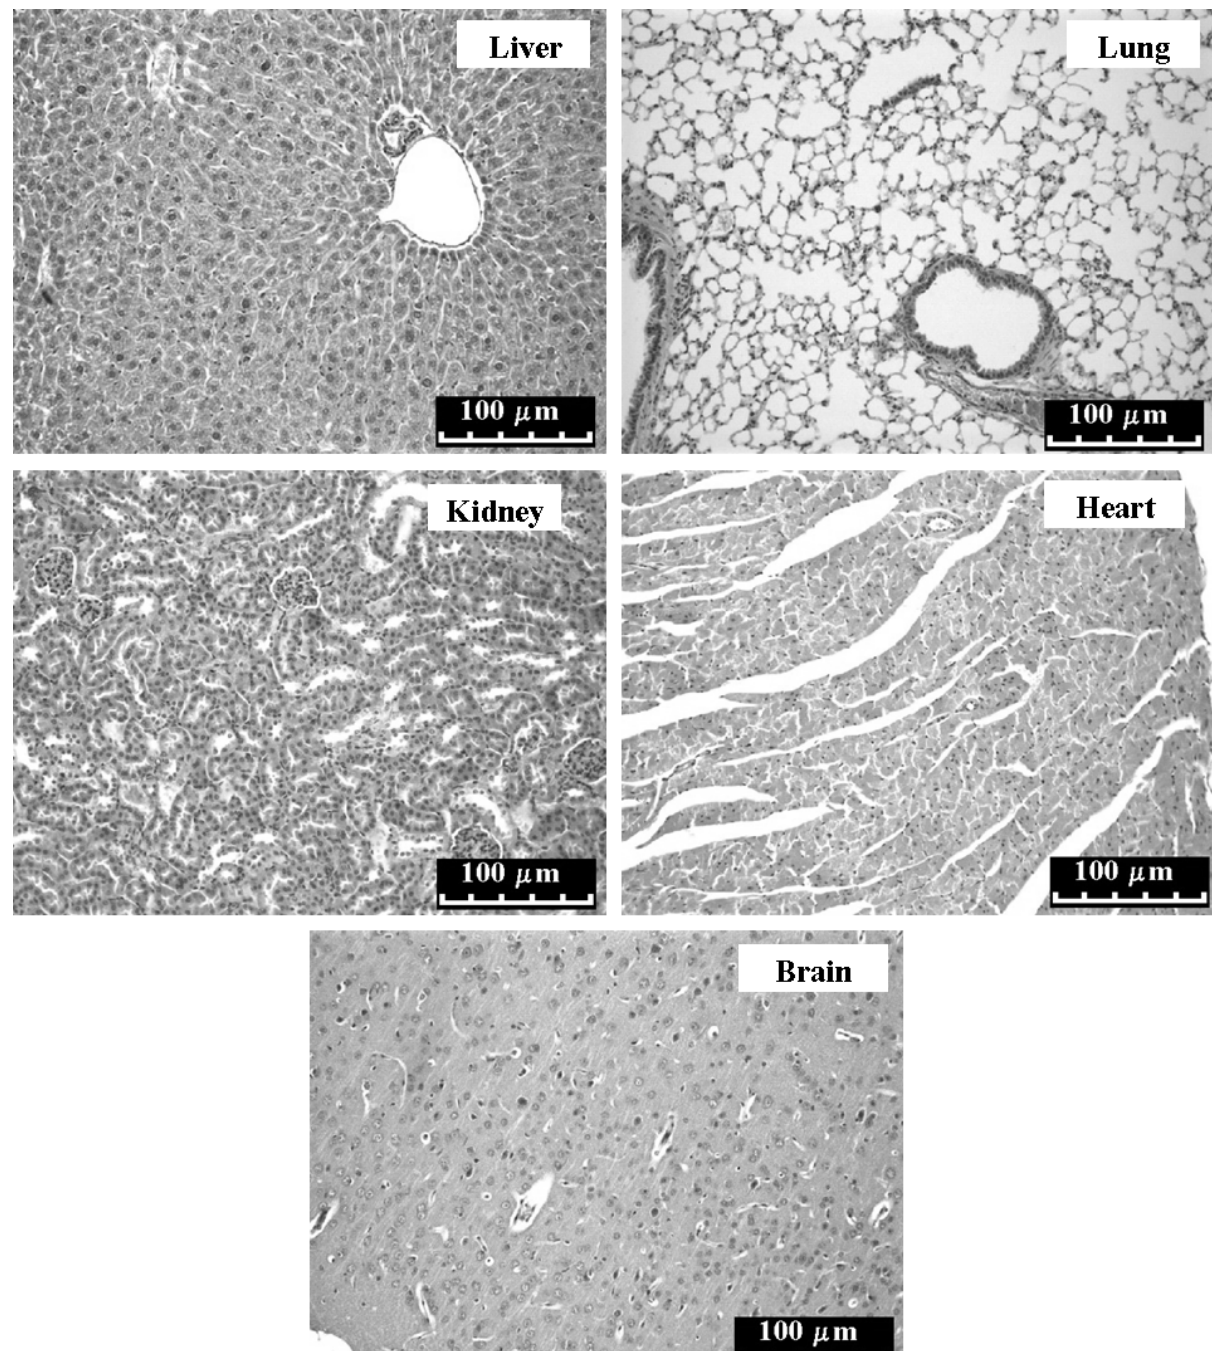
Figure 7. Liver, lung, kidney, heart and brain photomicrographs from a representative animal treated with the antitumoral CV dose established in vitro . No apparent morphological alteration was observed in the organs of the CV-treated